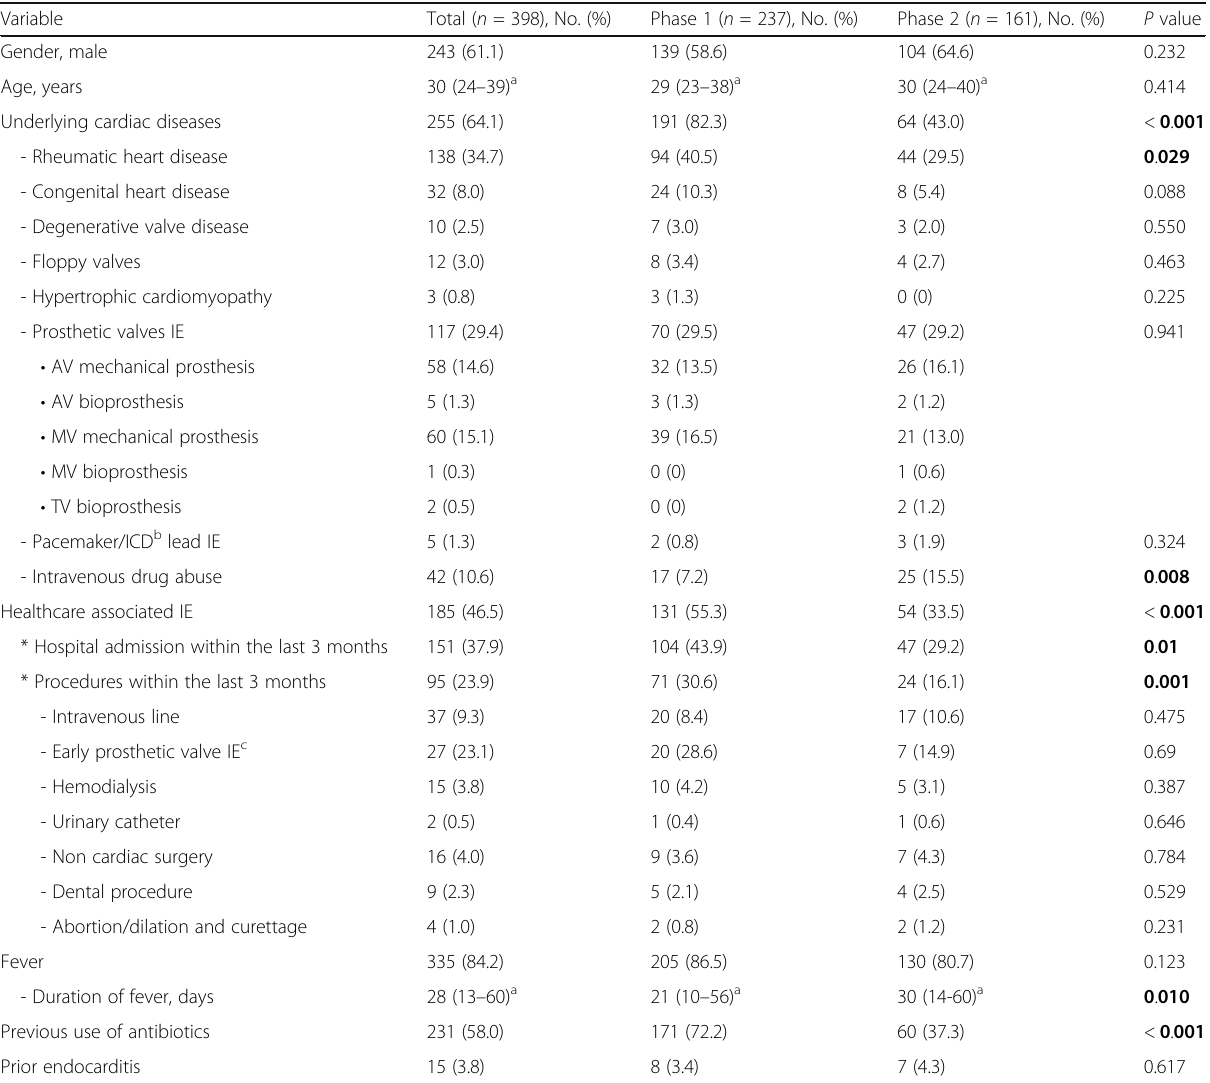
Table 1 Baseline clinical characteristics